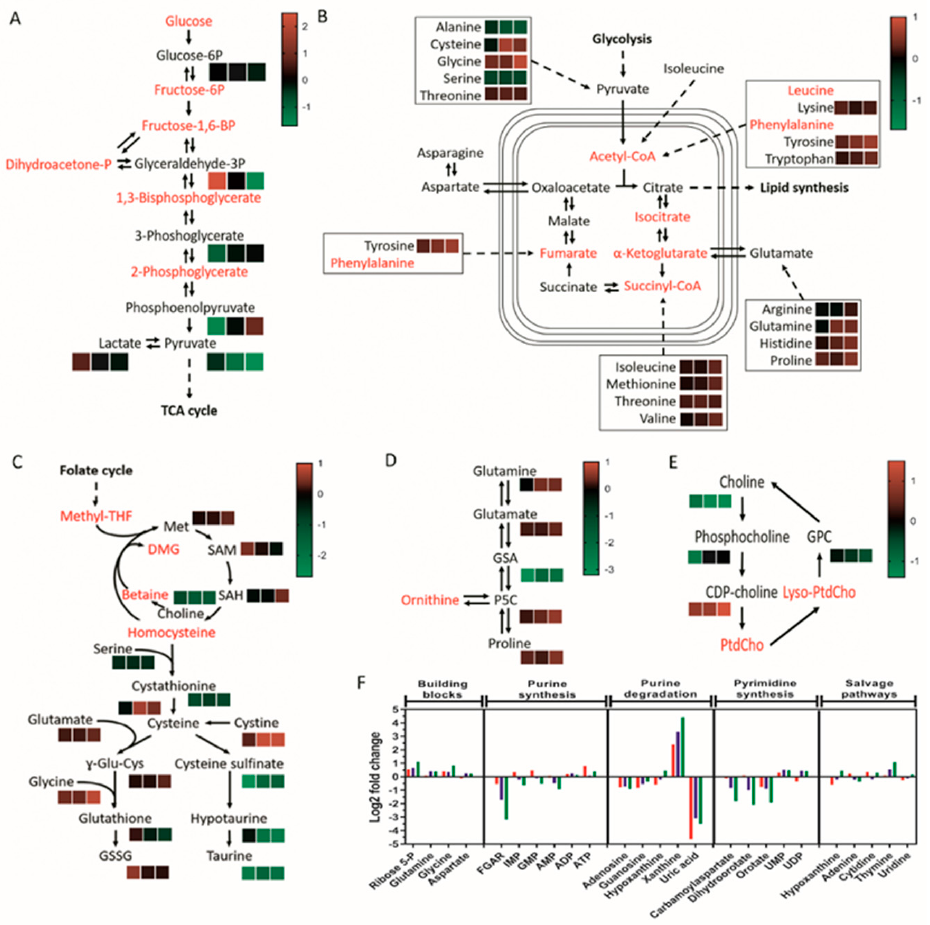
Figure 3. Lipoprotein starvation-induced perturbation of central metabolic pathways. Identified intermediates within glycolysis ( A ), TCA cycle and linked amino acid pathways ( B ), methionine cycle and transulphuration pathway ( C ), proline metabolism ( D ), choline pathway ( E ), and nucleotide metabolism ( F ) are depicted in black, with unidentified intermediates in red. ( A – E ) Heatmaps represent peak intensity fold changes between lipoprotein-replete and -deplete conditions in U373 (left box), KNS42 (middle box), and SF188 (right box) cells. Colour scales indicating the fold change range are specific to each panel. ( F ) Log2-fold peak intensity changes in nucleotide metabolism intermediates in U373 (red), KNS42 (blue), and SF188 (green) cells. Results are the mean of n = 6 independent replicates.